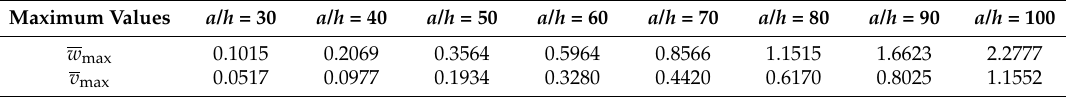
Figure 7. Dynamic deflections of center point of the plate versus time for different ratios a/h. ( a ): Nondimensional deflection w versus time, ( b ): Nondimensional velocity v versus time. Table 5. Maximum deflections, velocities and stress of the plate center point versus time for different ratios a/h.